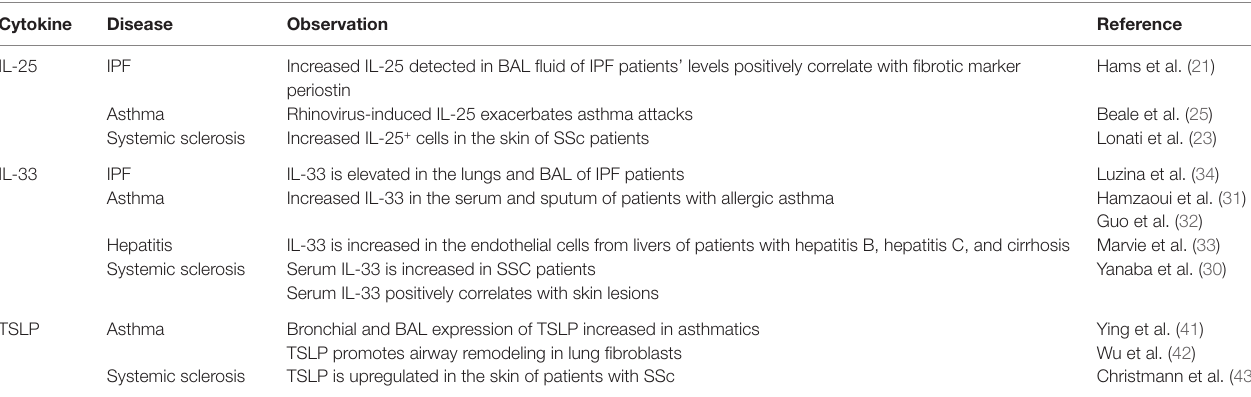
TABLe 1 | expression of selected epithelial-derived cytokines in human fibrotic diseases. Cytokine